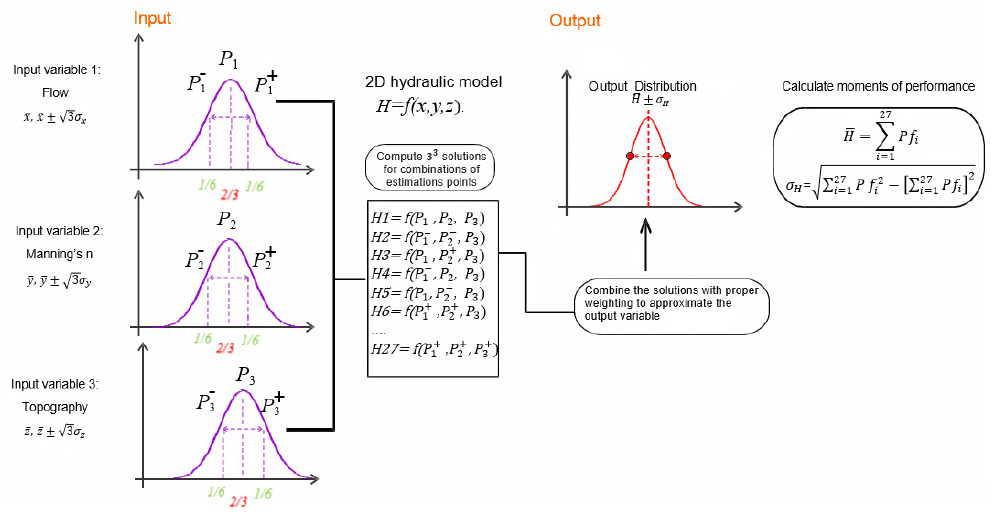
Figure 4. Basic principles of the point estimate method for estimation of the statistical moments of the output parameter based on three independent normal random input variables (H , σ H ) are the mean and the standard deviation of water depth. Table 3. The conditions for uncertainty analysis of topography, Manning’s and flow rate using the PEM method.